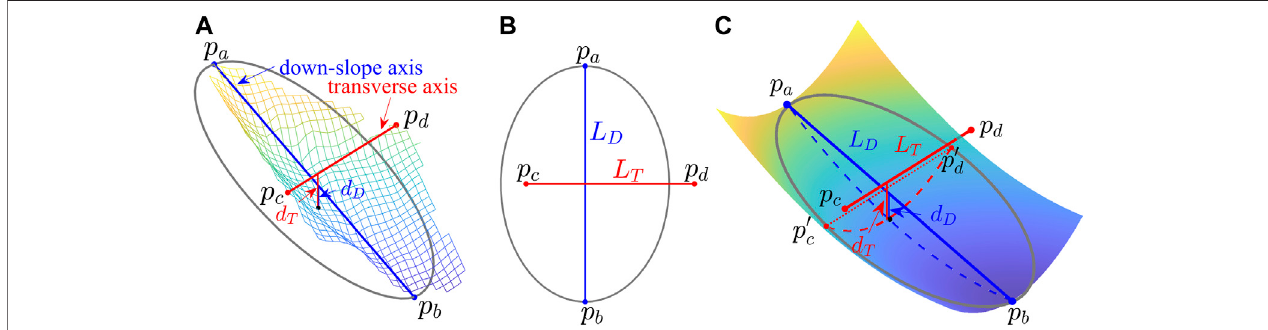
FIGURE 1 | (A) The main (down-slope) axis and the transverse axis of a failure surface, which are perpendicular to each other in the top view and with depths, d D and d T , respectively. (B) The top view and the regressed ellipse. (C) The constructed idealized curved surface (ICS). It is noted that p c and p d lie at the scarp boundary, while p c ′ p d ′ denotes the minor axis of the reference